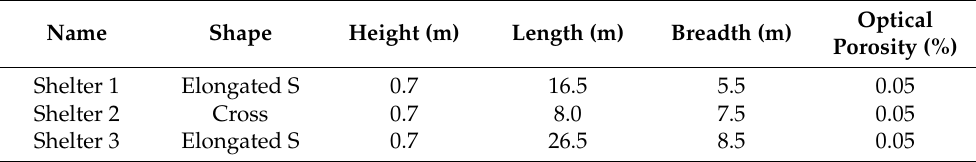
Figure 1. Satellite image of the study area demonstrating natural (band of vegetation at the northern boundary of the field) and artificial shelters (black symbols). Getmapping Plc© (Fleet, UK). Table 1. Description of artificial shelters, shape, physical dimensions, and optical porosity used to evaluate the shelter-seeking behaviour of sheep. Reproduced from Pritchard et al., 2021 [3].